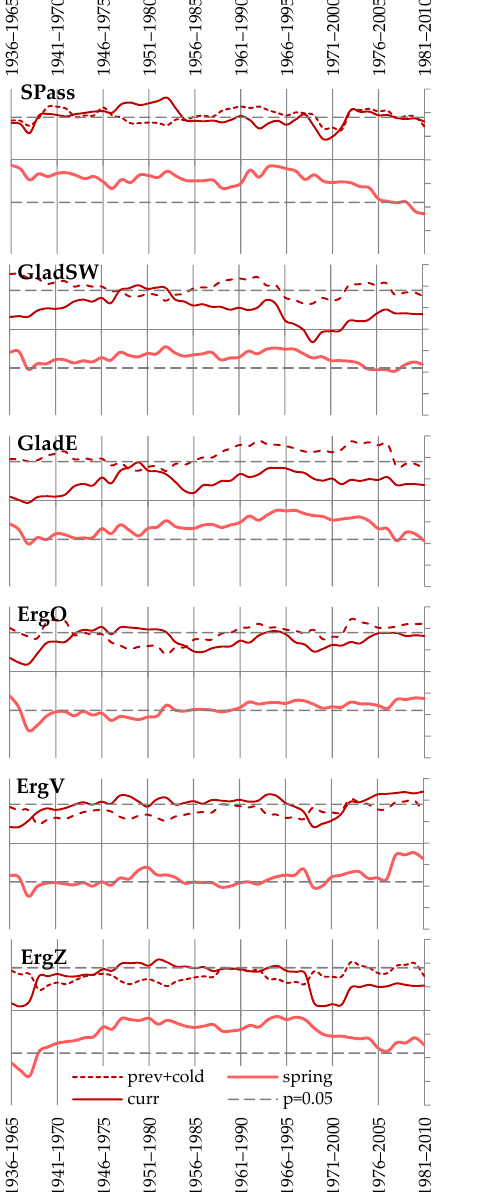
Figure 3. Temporal stability of the P. sibirica climatic response: 30 year moving correlations between residual TRW chronologies and series of temperature (left column) and precipitation (right column) over respective intra-seasonal intervals (see Table 3; prev , second part of previous vegetation season; cold , cold season; spring , early spring season; curr , first part of current vegetation season). Significance level p = 0.05 for 30-year interval is depicted by the horizontal dashed